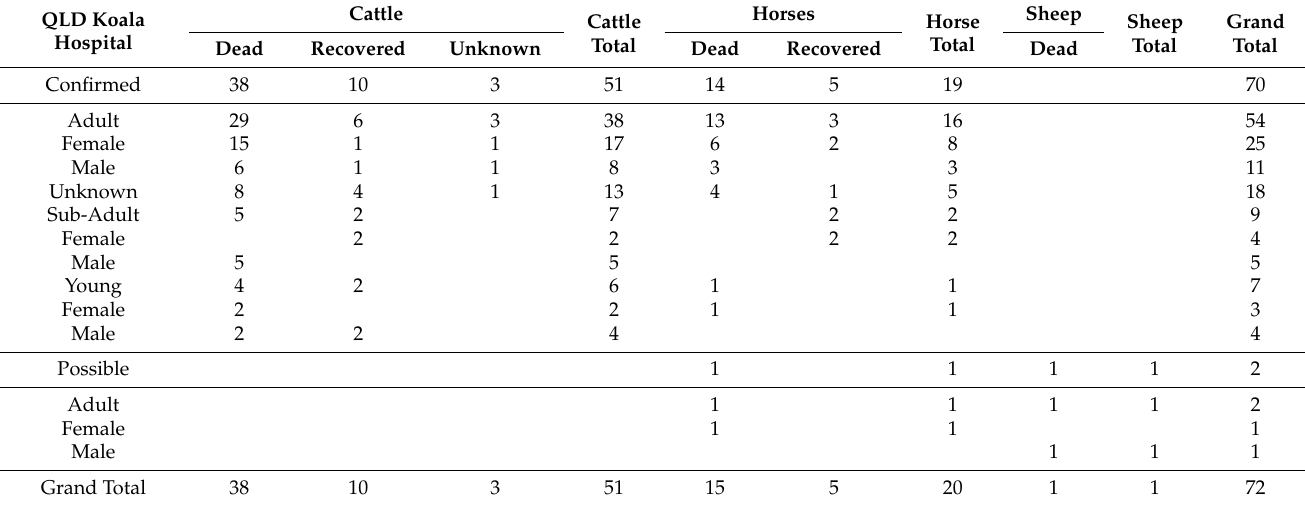
Table 2. Summary of confirmed and possible livestock-related incidents to koalas, with the outcomes from each livestock type, and the sex and age class of koalas admitted by Queensland wildlife hospitals from 1997 to 2019. Age class of koalas was categorised by body mass: Adult (>4 kg), Sub-Adult (2–4 kg) and Young (<2 kg). Recovered koalas were those released into the wild after admission and treatment at the